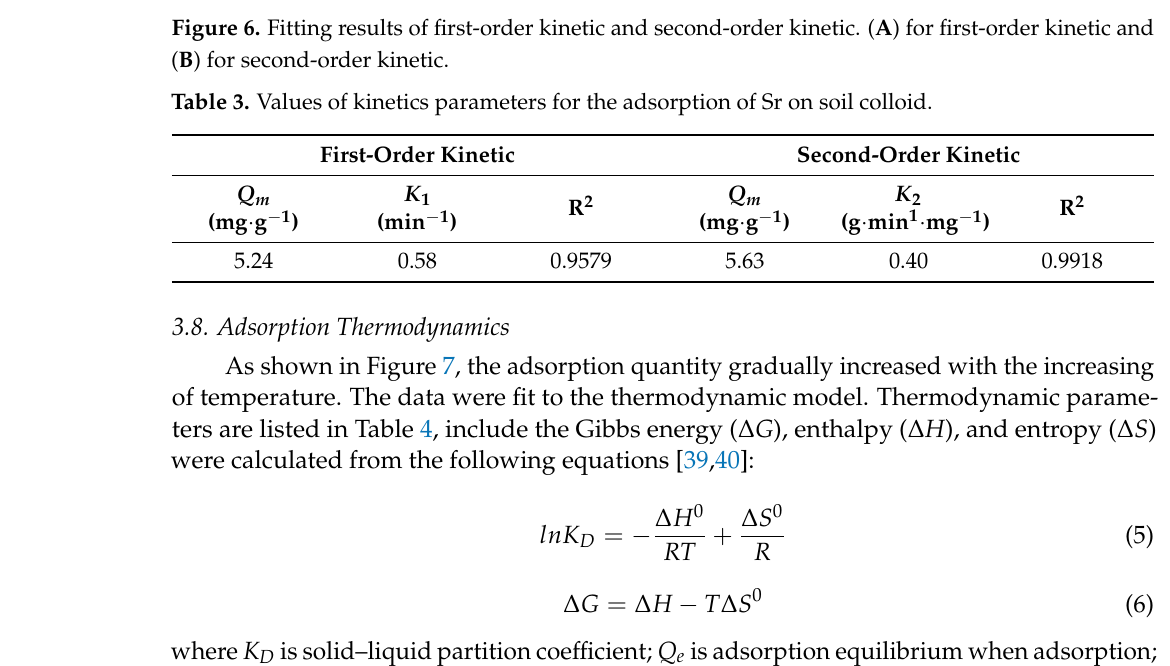
Figure 7. Effect of temperature on adsorption of Sr on soil colloids. Soil-liquid rate = 0.8 g·L −1 , pH = 6 ± 0.1, C[Sr 2+ ] inital = 100 mg·L −1 .